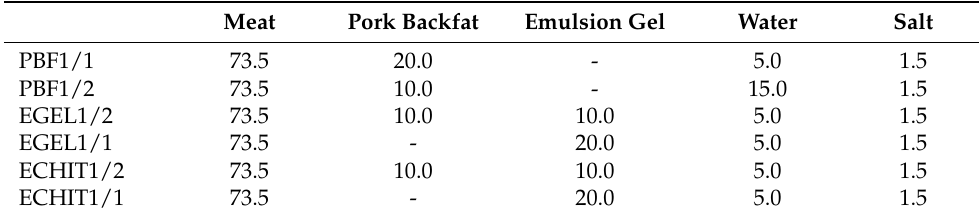
Table 1. Formulation (g/100 g) of different patties